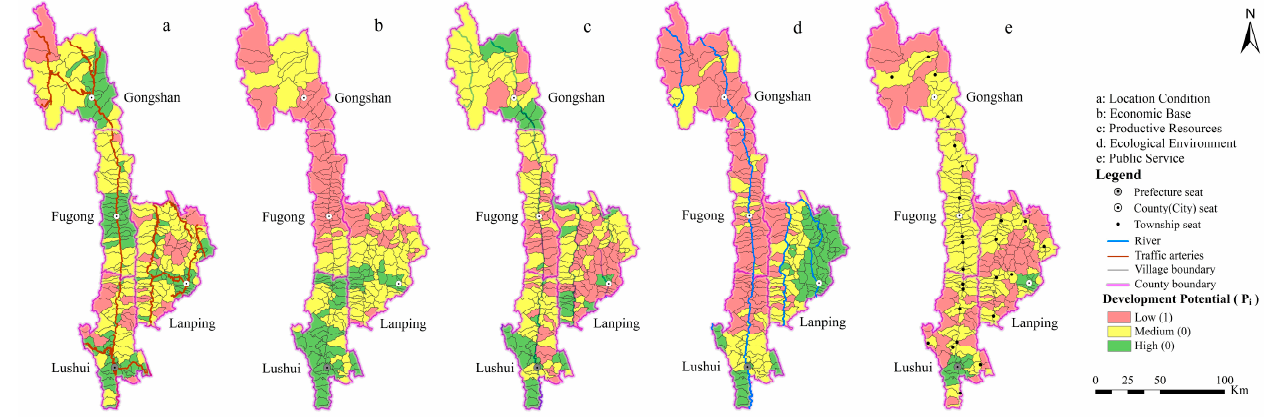
Figure 3. Classification of livelihood capital and relative poverty in villages of Nujiang Prefecture. Table 3. Distribution of poverty villages in different watersheds in Nujiang Prefecture. Development